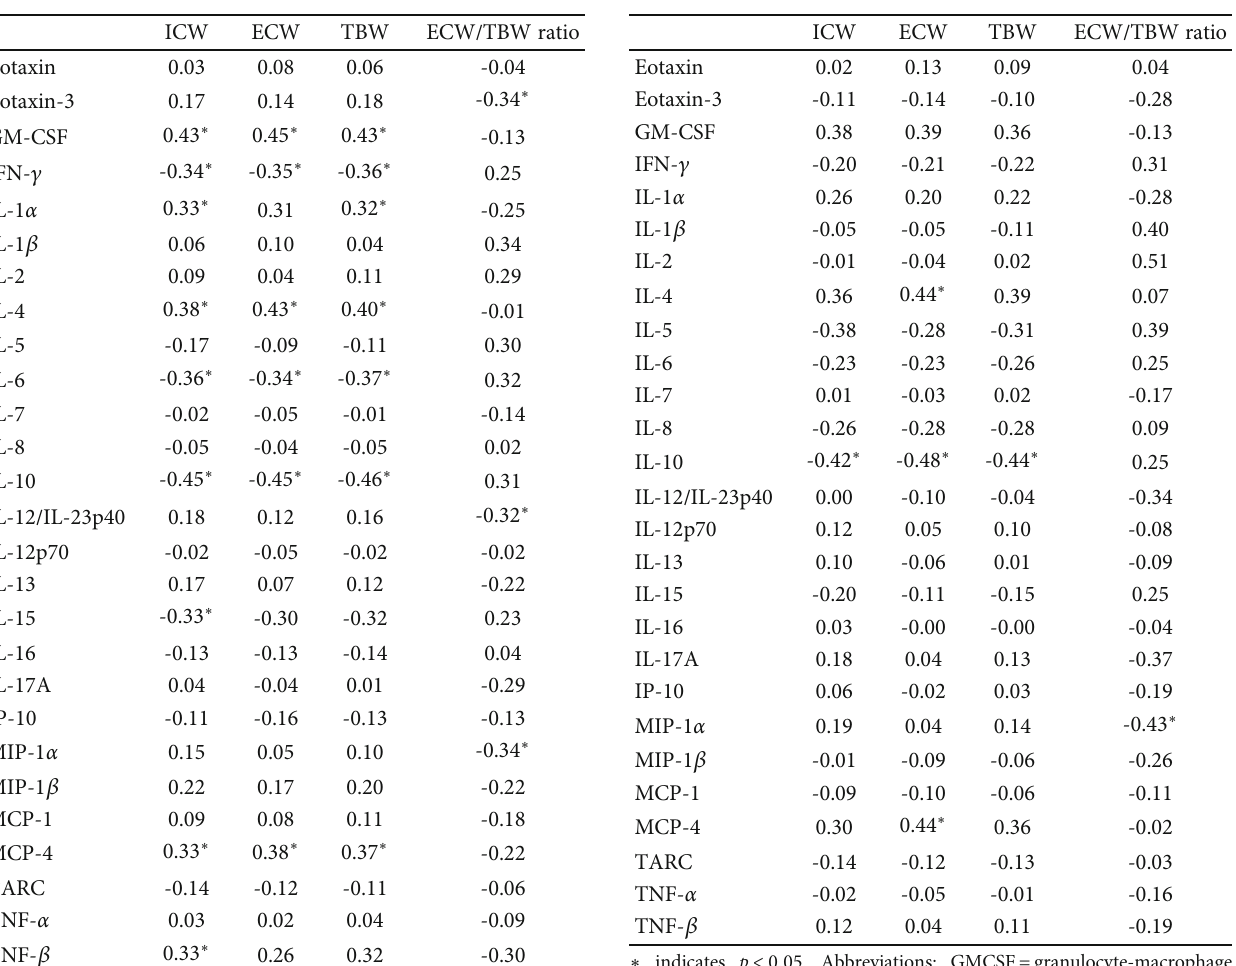
Table 3: Correlations ( r ) between cytokine concentrations and s water distribution variables in the whole sample.